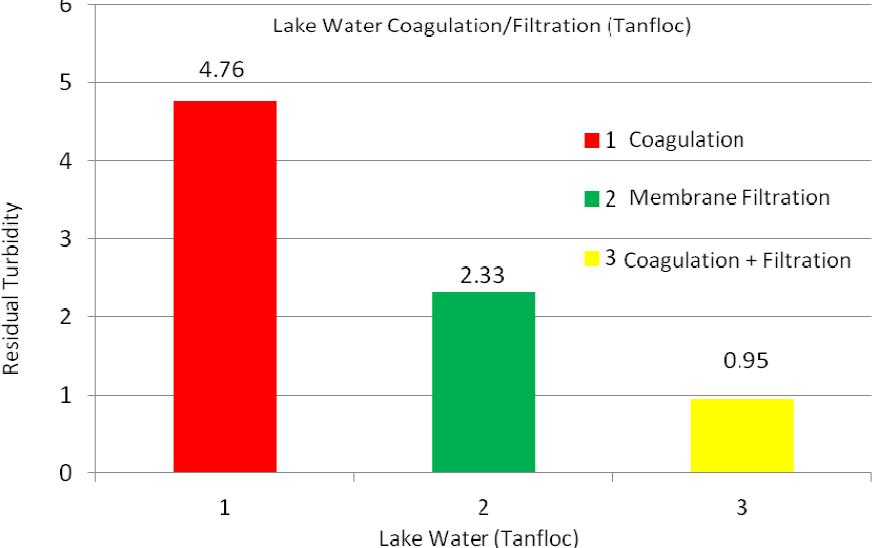
Figure 3. Turbidity values of lake water using Tanfloc coagulation, membrane filtration, and coagulation + filtration processes; coagulation tests conducted using 15 mg/L Tanfloc after 1 h of settlement in flask, while filtration tests performed using Buchner filter after same amount of